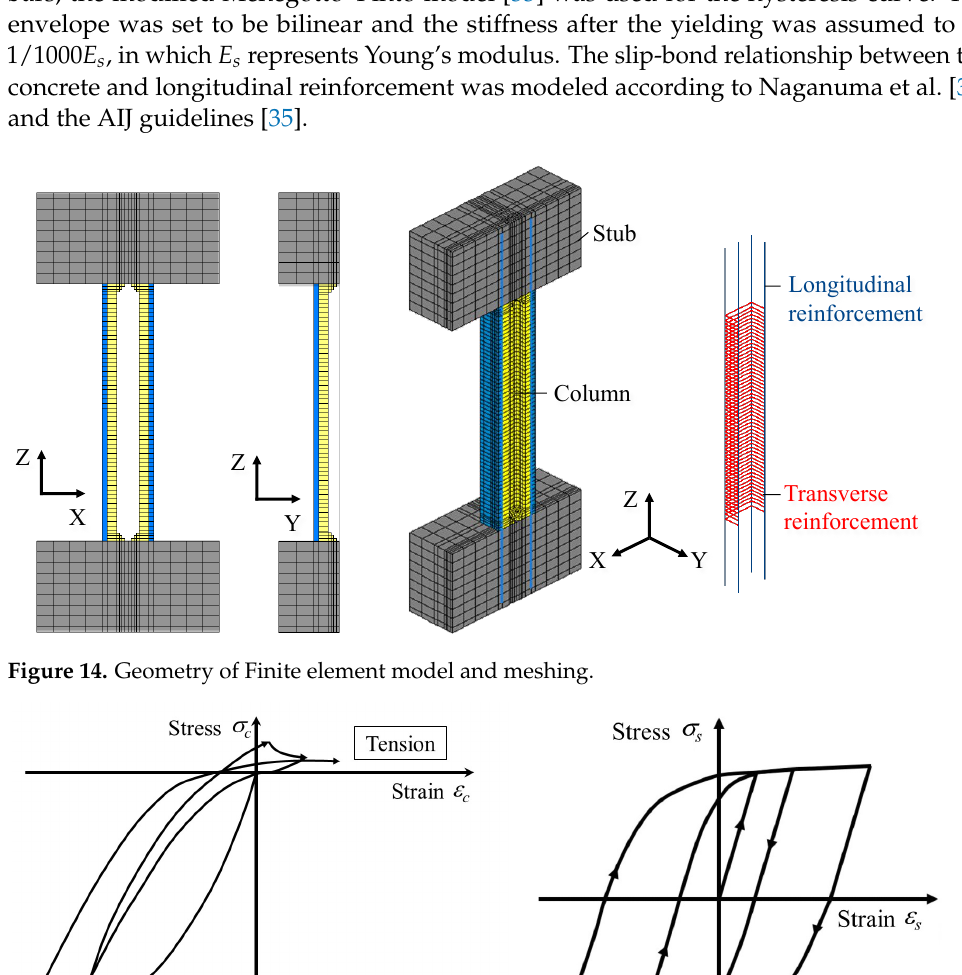
Figure 14. Geometry of Finite element model and meshing.